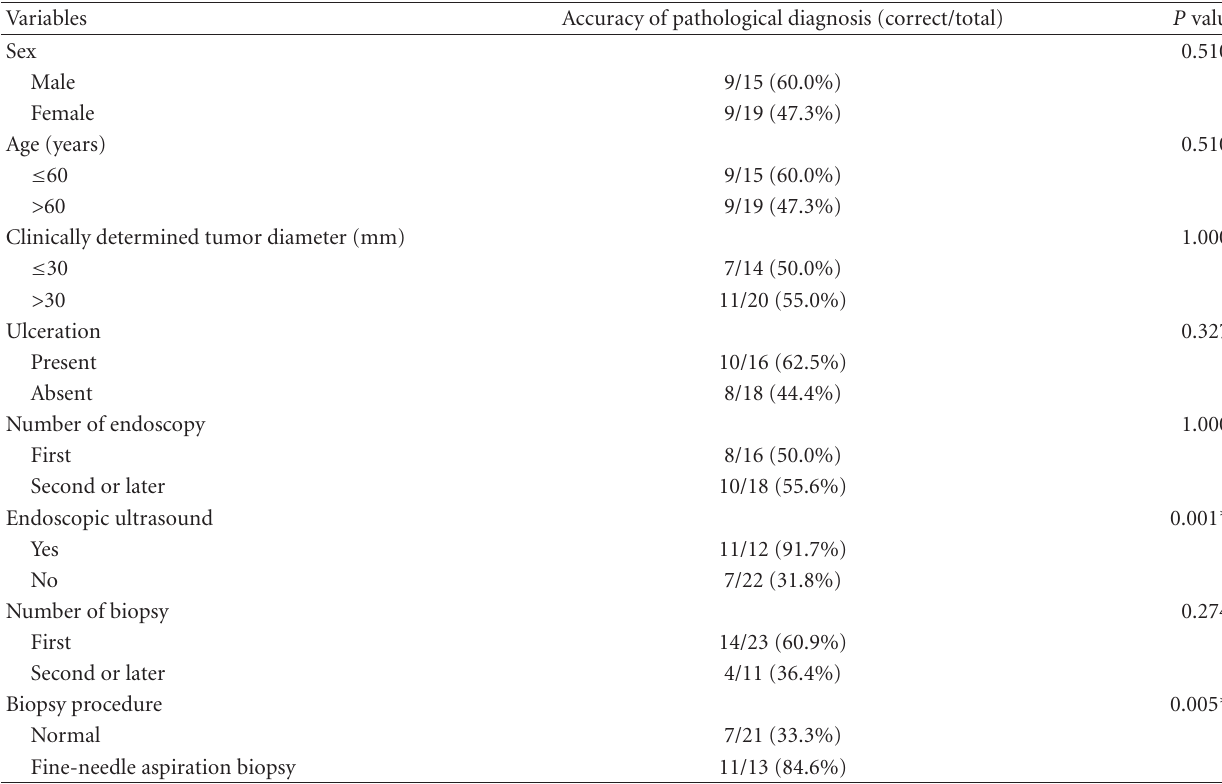
Table 2: Univariate analysis (34 biopsies).